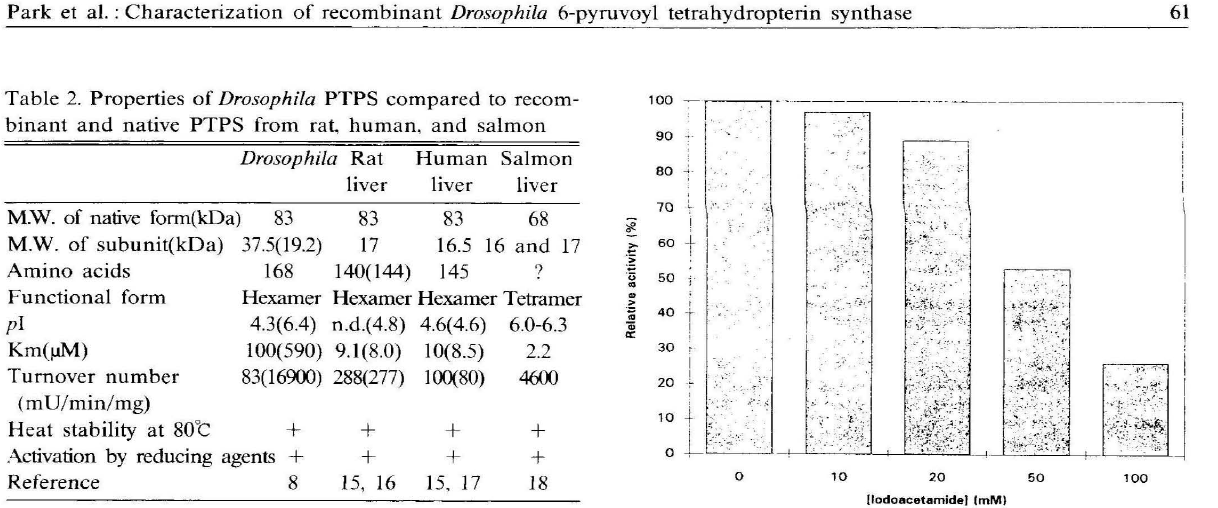
Table 2. Properties of Drosophila PTPS compared to recom binant and native PTPS from rat, human, and salmon Drosophila Rat Human Salmon liver liver liver M.W. of native form(kDa) 83 83 83 68 M.W. of subunit(kDa) 37.5(19.2)